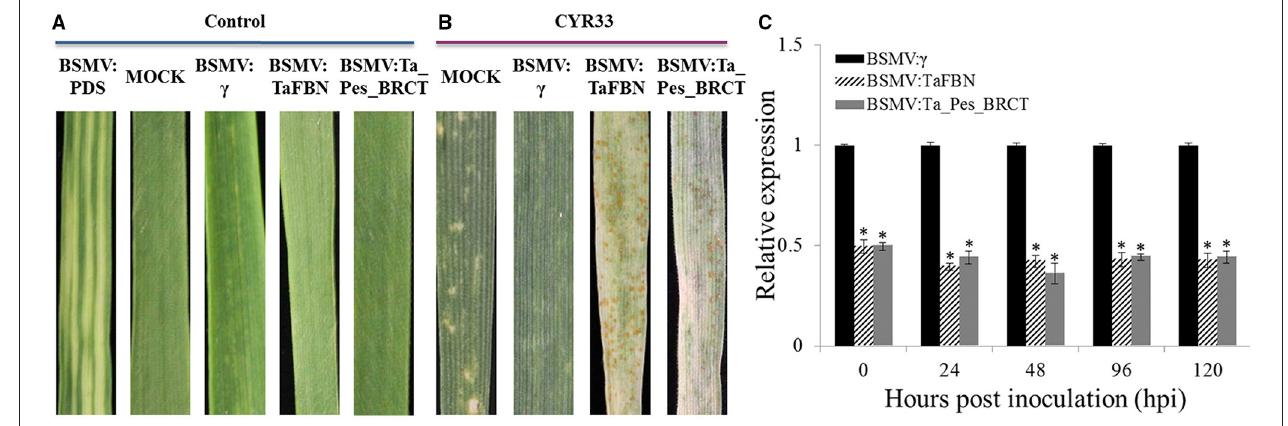
FIGURE 3 | Transient silencing of TaFBN and Ta_Pes_BRCT with the BSMV-VIGS method. (A) Wheat leaves treated with 1 × Fes buffer (MOCK) show no phenotypic changes. Mild chlorotic mosaic symptoms were detected on the plants inoculated with BSMV: γ , BSMV:PDS, BSMV:TaFBN, or BSMV:Ta_Pes_BRCT. (B) Phenotypes of the fourth leaves infected with uredospores of Pst race CYR33 at 10 days post inoculation. (C) Silencing efficiency assessment of TaFBN in the TaFBN-knockdown plants and Ta_Pes_BRCT in the Ta_Pes_BRCT-knockdown plants. Error bars represent the standard deviations of three independent samples. The significance of differences is indicated by asterisks and tested using Student’s t -test ( P <